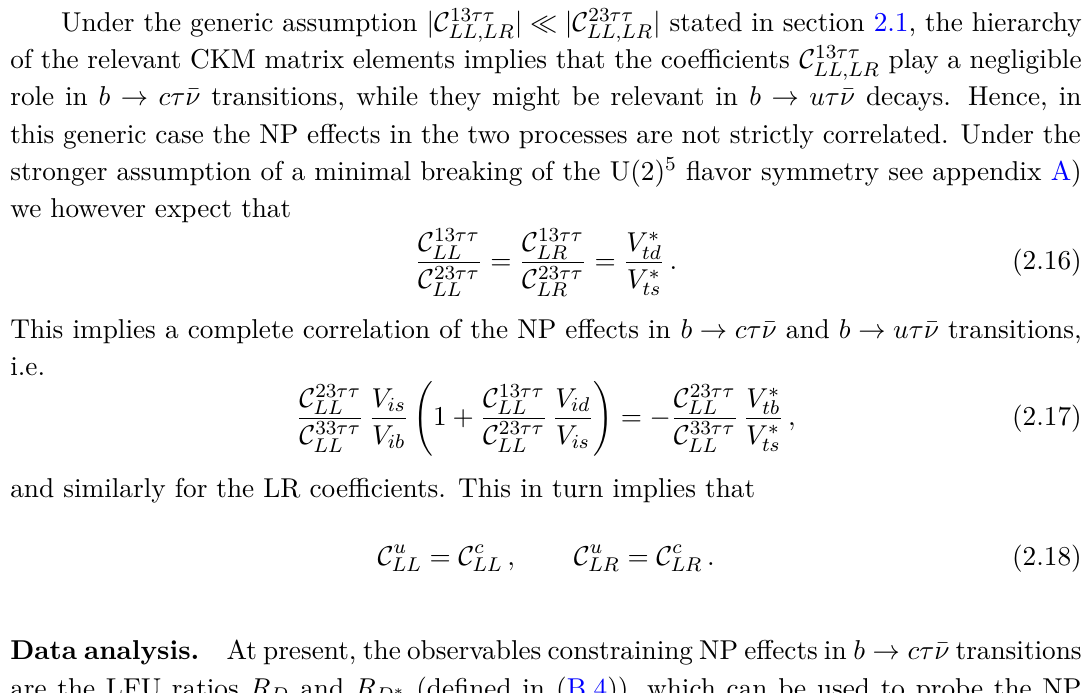
Figure 2 . EFT constraints from the b → cτ ¯ ν anomalies. The solid blue ellipses denote the 1 σ , 2 σ and 3 σ intervals of the two-dimensional fit to R evaluated at Λ = 2 TeV ). The dashed contours denote the fit results taking also the constraint from B ( B − → τ ¯ ν ) into account, under the hypothesis of minimal U(2) 5 breaking (i.e. for C u = C c ). The bands correspond to 1 σ regions. The red lines show the benchmark scenarios we C u LR LR consider in our